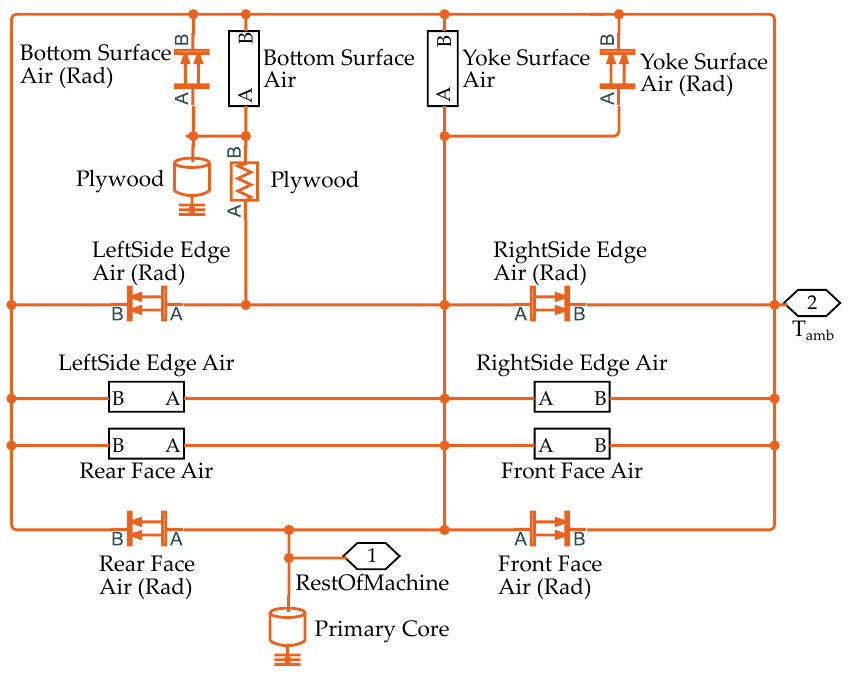
Figure 4. Thermal network for the primary